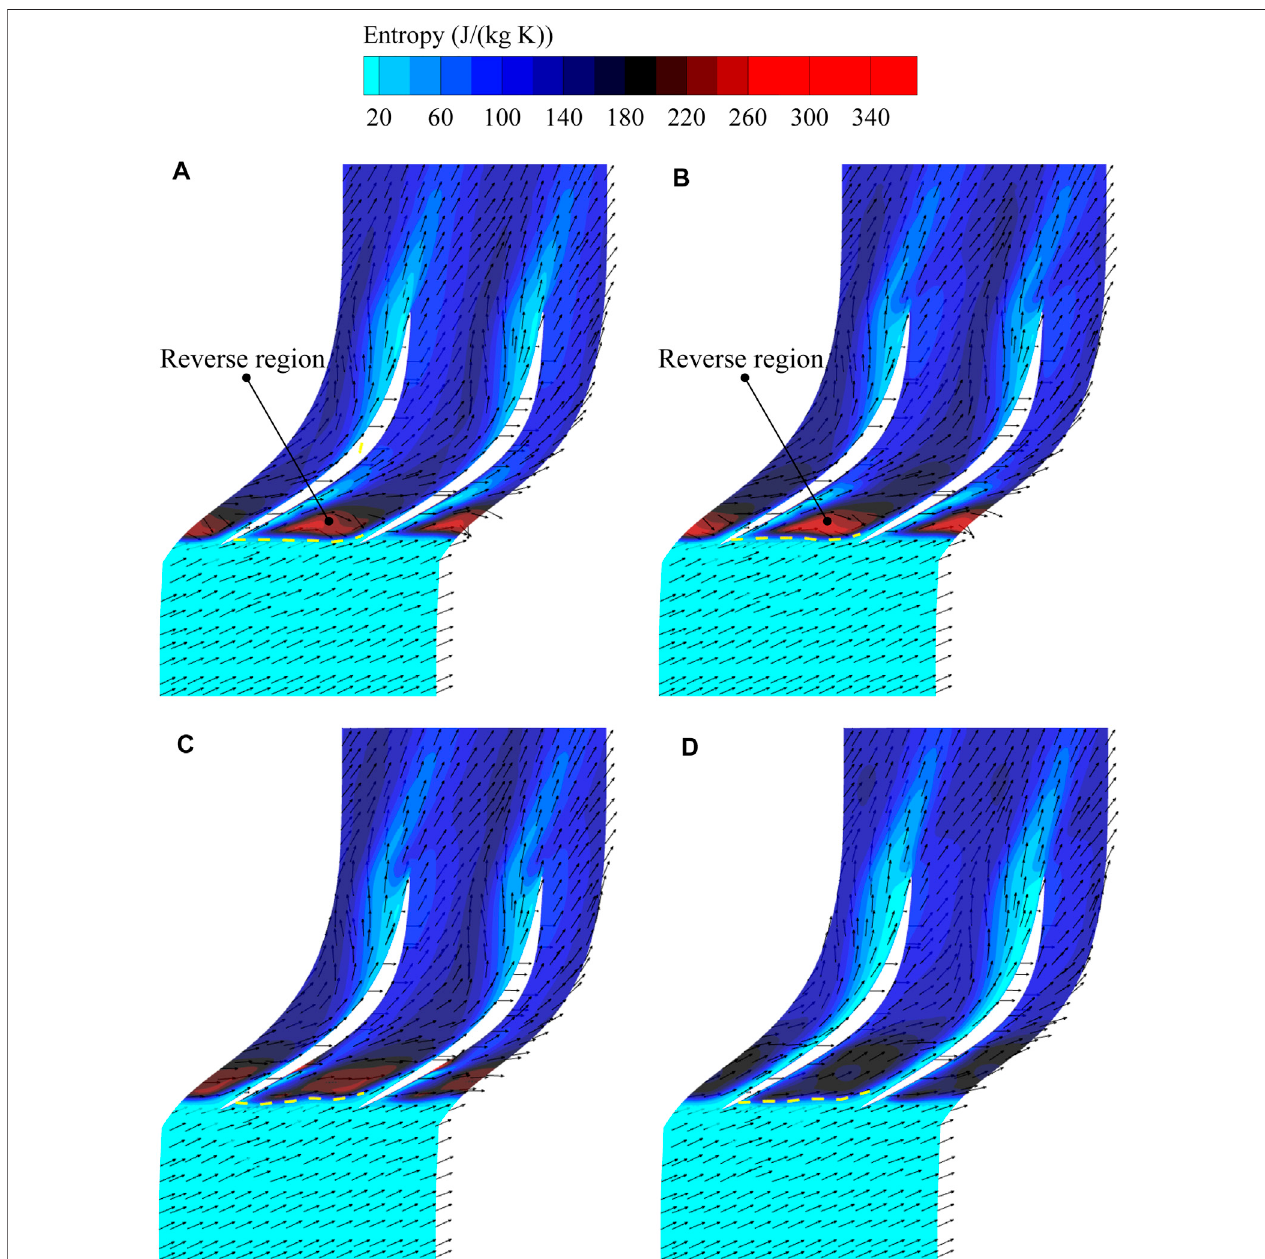
FIGURE 11 | Entropy contours and velocity vectors at 98% span. (A) Smooth casing (B) Max PEI point (C) TOPSIS point (D) Max SMI point.